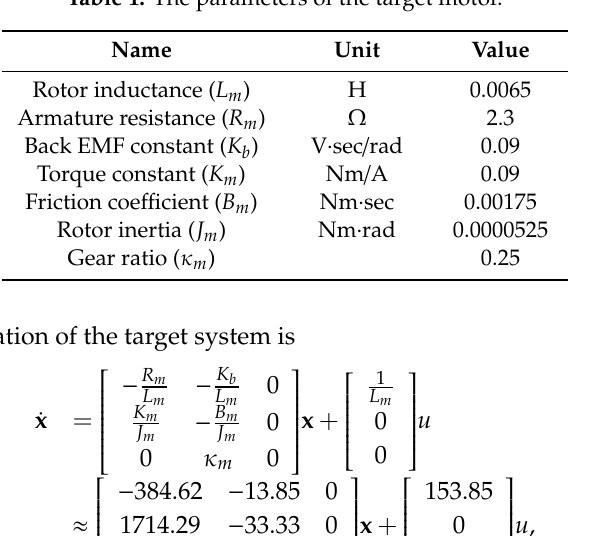
Table 1. The parameters of the target